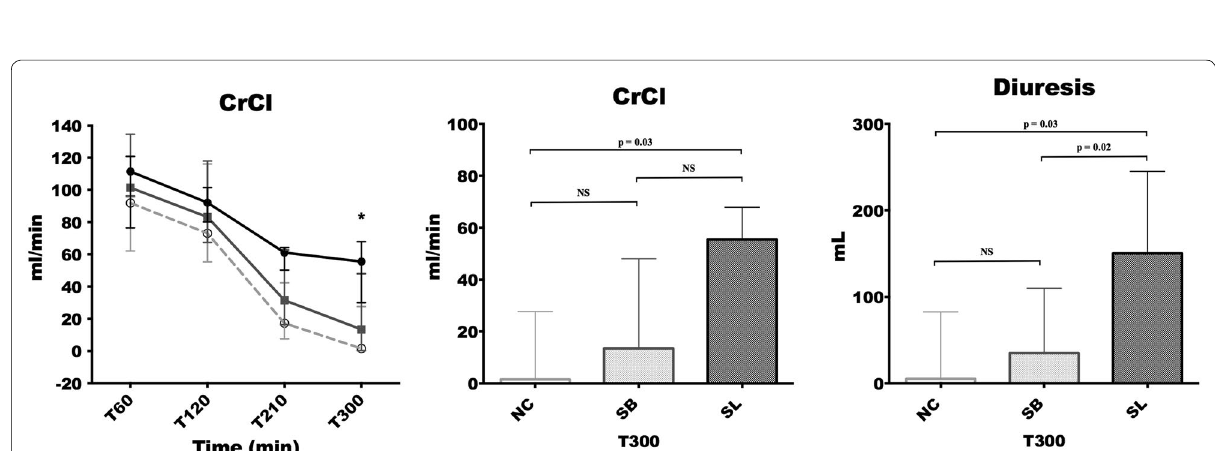
Fig. 5 Creatinine clearance (CrCl) and diuresis in the three groups. Open circles and dotted line: NC group ( n ( n 5); closed circles and black line: SL group ( n = SB versus SL. & p < 0.05, NC versus